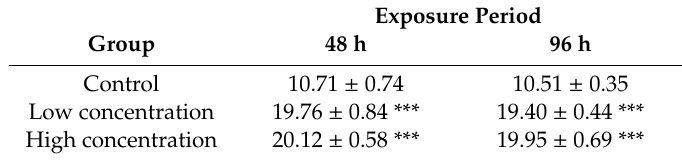
Table 3. Quantification of Na + / K + -ATPase protein in the control group and after exposure to